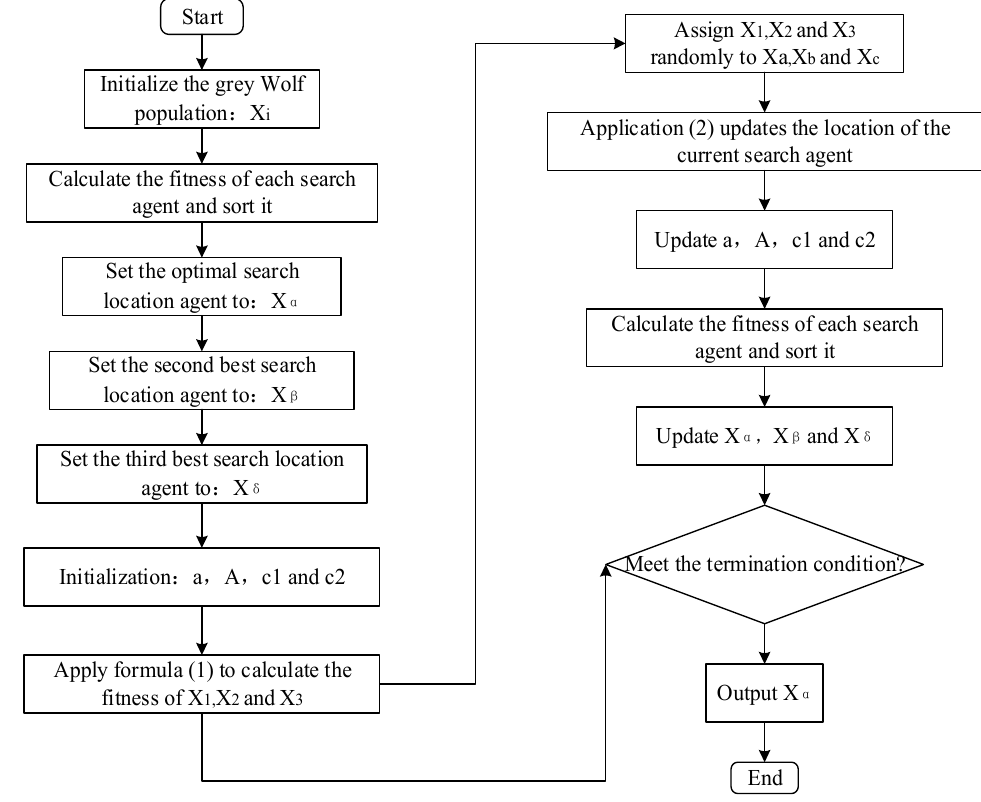
Figure 4. DE-GWO algorithm flow